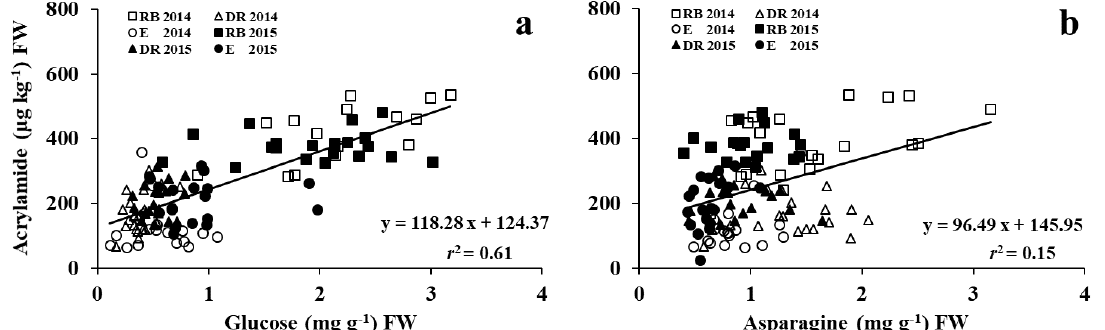
Figure 7. Relationships between acrylamide and glucose ( a ) or asparagine ( b ) concentrations of Russet Burbank, Dakota Russet, and Easton after 16 weeks of storage in 2014 and 2015.